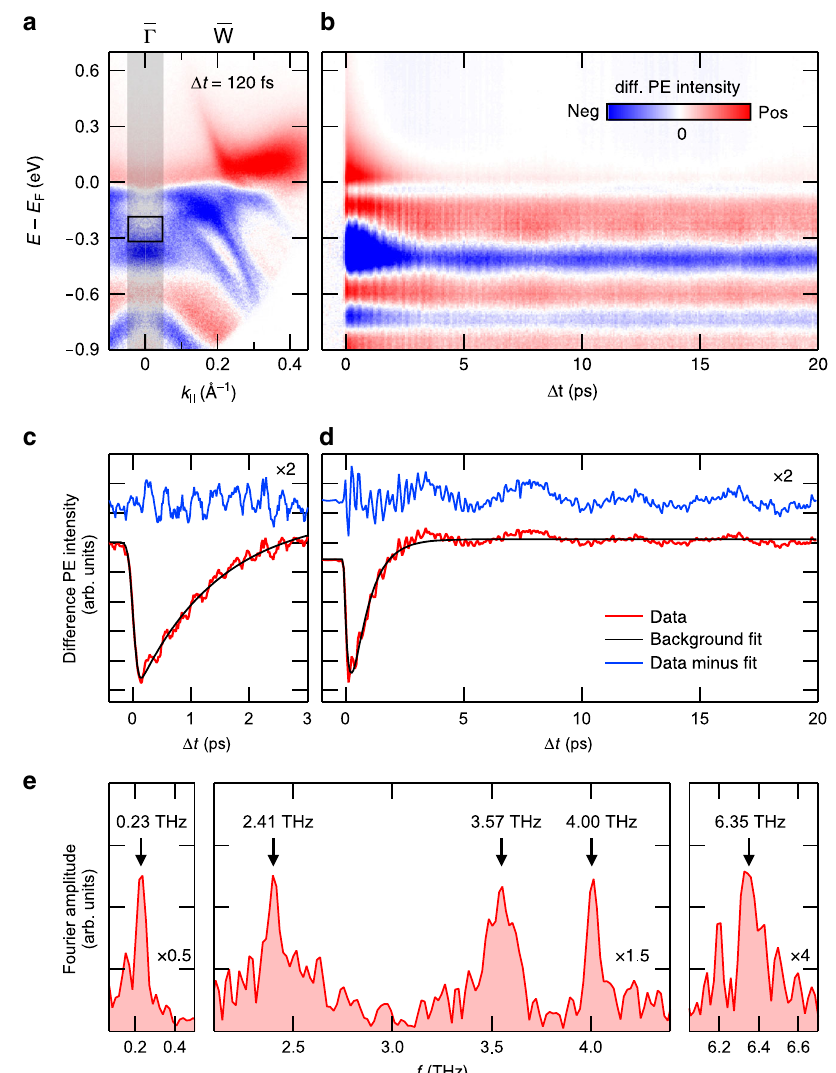
Fig. 2 TRARPES results of Td -WTe 2 along Γ -W. a ARPES difference intensity map derived from the TRARPES data at Δ t = 120fs and Δ t = − 1ps shown in Fig. 1c. b Transient difference EDCs derived from the ARPES difference intensity map by momentum integration of the gray-shaded area in a . c , d PE intensity transients of the integration region marked by the black box in a before (red) and after (blue) background subtraction (Supplementary Note 3). Blue curves are offset and scaled by a factor of 2 for clarity. e Fourier amplitude spectrum of the intensity transient shown in d . Note the different scaling of the